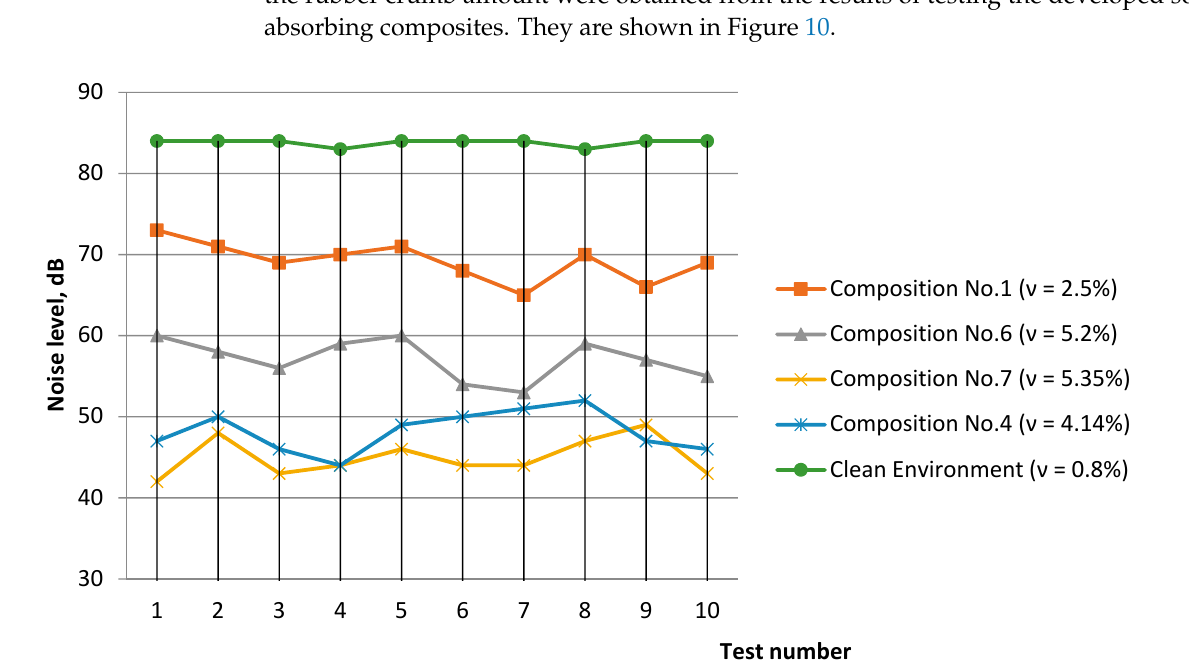
Figure 10. Results of the samples test for sound absorption ( ν -coefficient of variation).